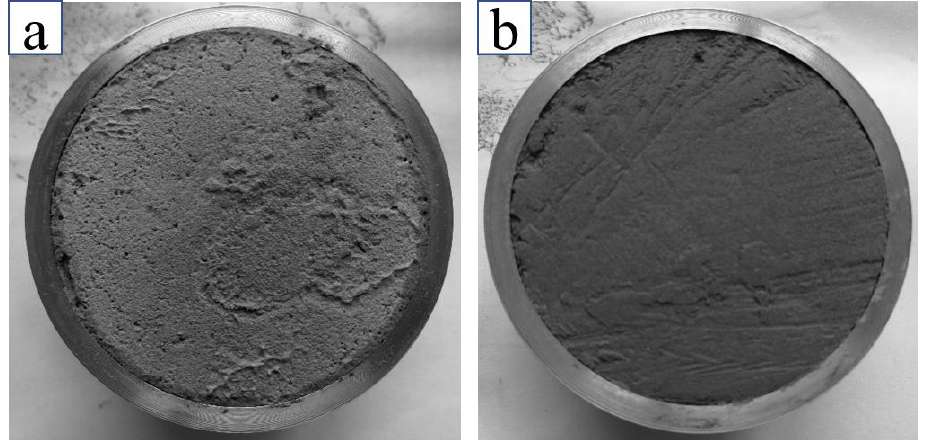
Figure 7. Comparison of penetration samples: ( a ) 0%; ( b ) 0.6%.